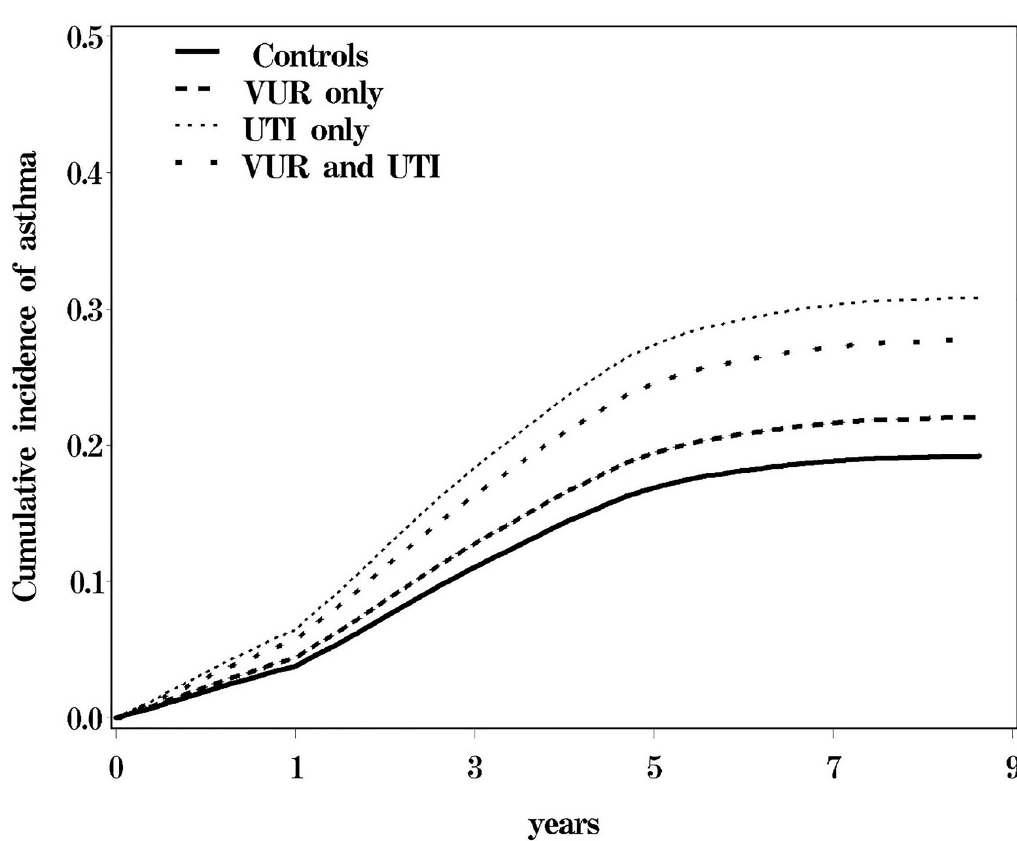
Fig 1. The Kaplan-Meier analysis of cumulative incidence of asthma among children with vesicoureteral reflux (VUR), urinary tract infection (UTI) and VUR and UTI compared to control cohort.